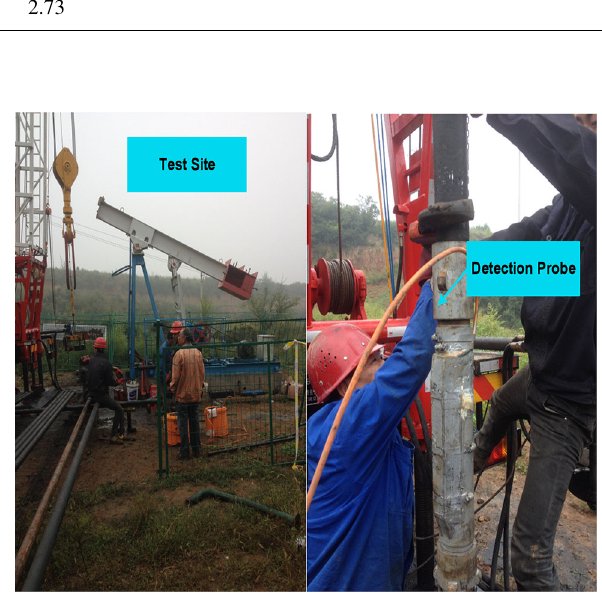
Fig. 8 Field photographs to show the detection probe entering a